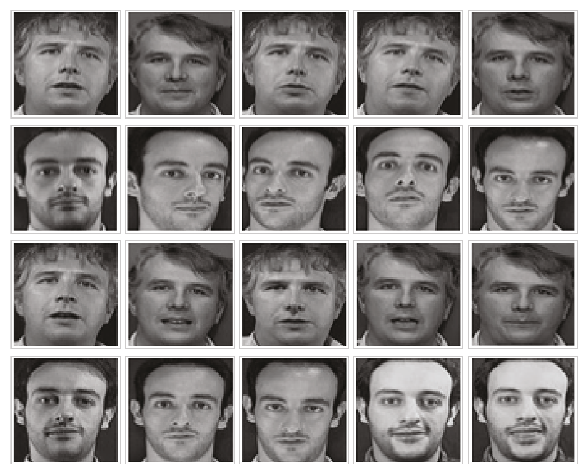
Figure 13: Example ORL images used in our experiments (resized to 128 × 128). The figure shows two subject images, where the first 2 rows used for training and the second 2 rows used for testing.